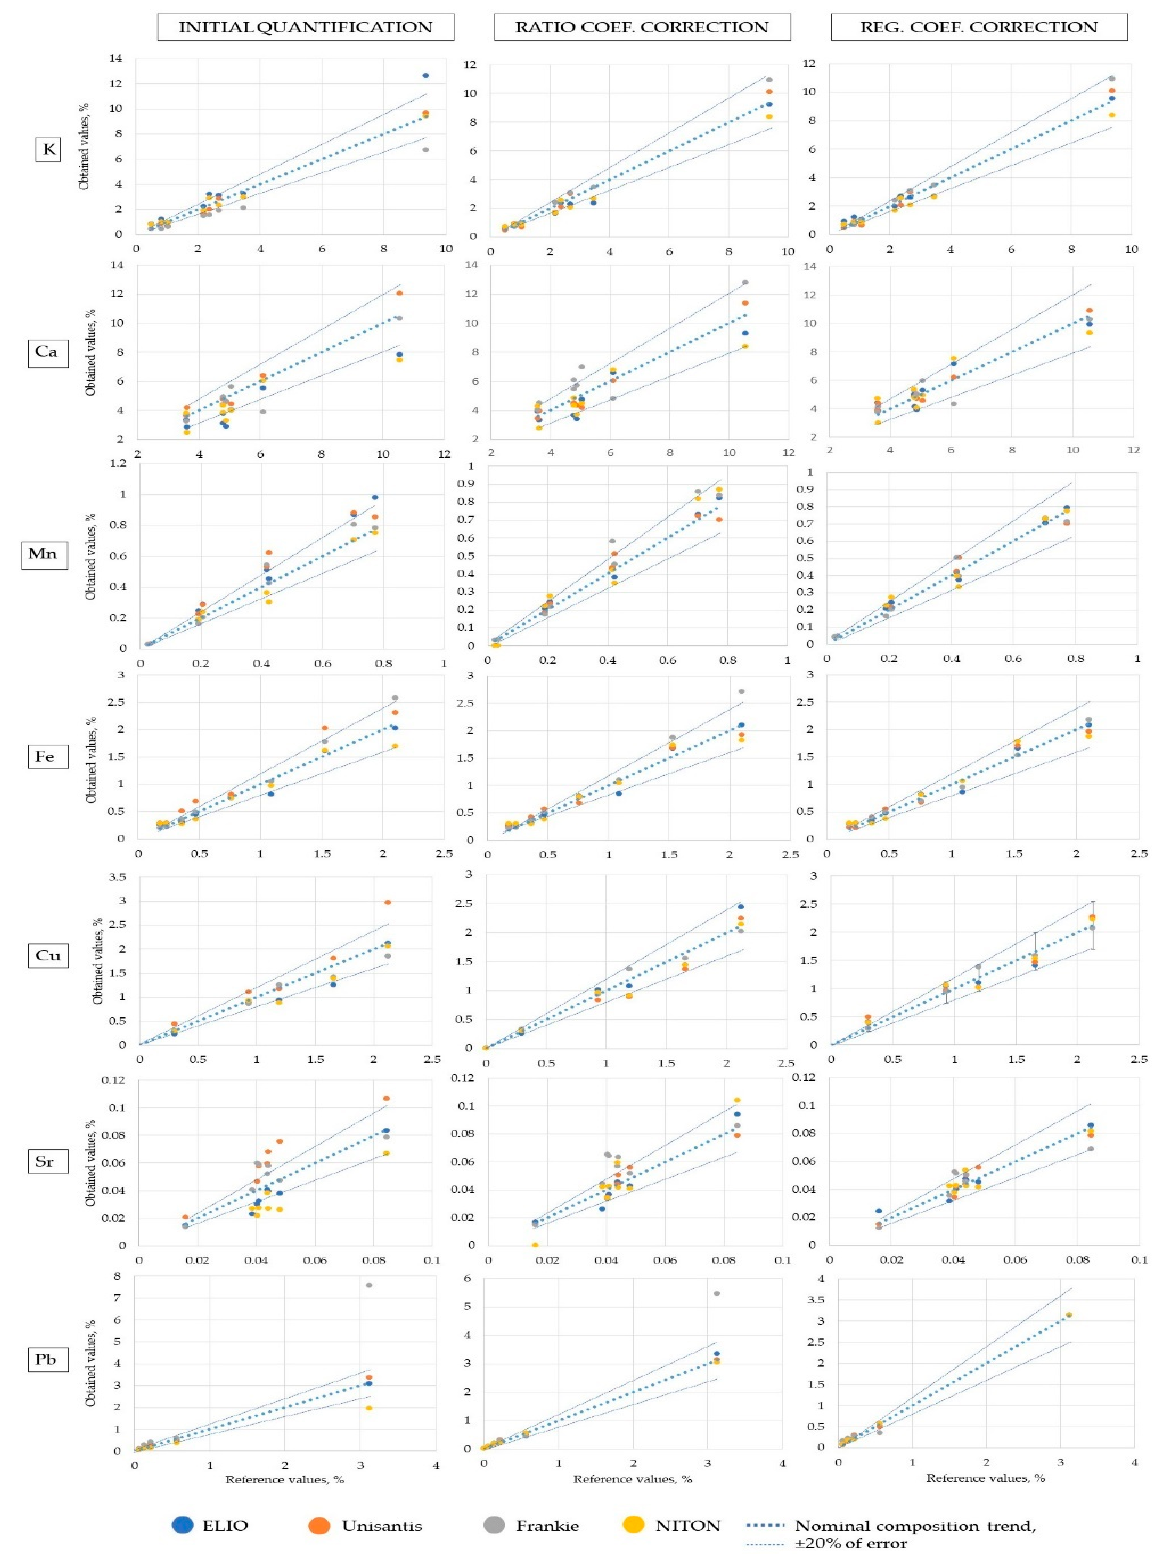
Figure 6. Binary plots of three kinds of quantification against the nominal concentrations. Nominal values are plotted against themselves to demonstrate the correct regression line. Twenty percent of the error along the nominal curve is marked by thinner dotted lines.